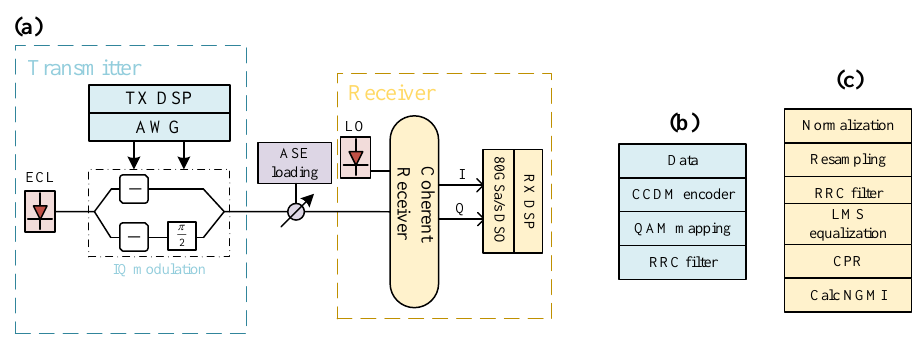
Figure 6. ( a ) Experimental setup, ( b ) transmitter-side DSP flow, and ( c ) receiver-side DSP flow.